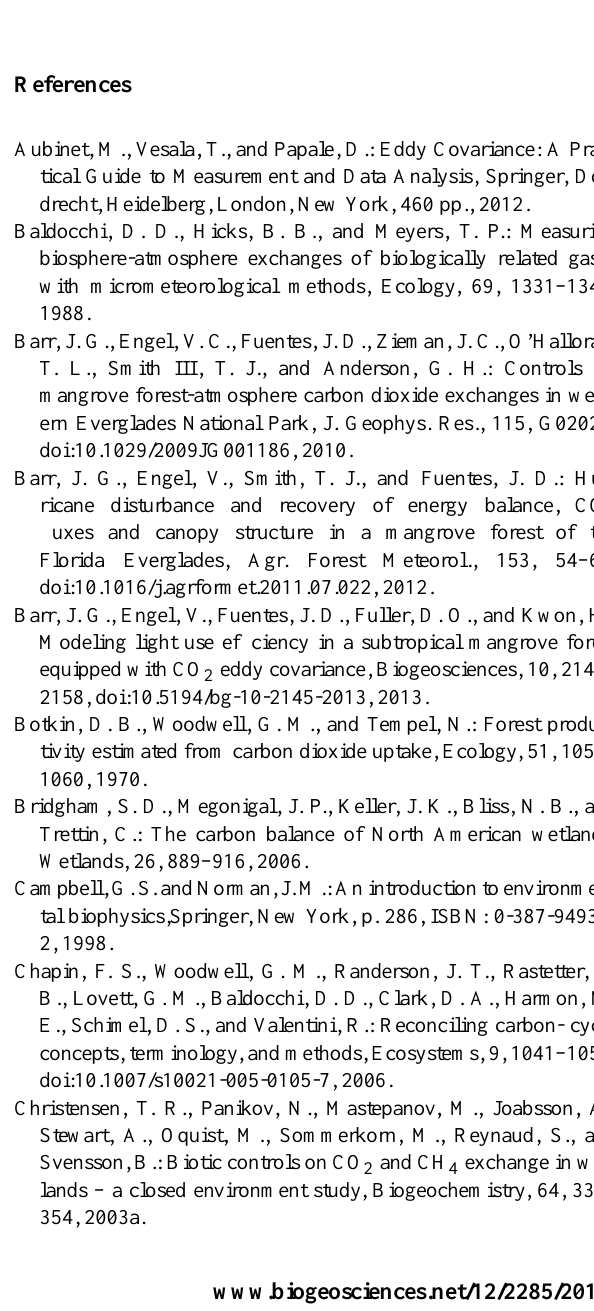
Table 6. Comparison of annual totals of NEE for different studies. Ecosystem NEE ∗ Climate Reference Taylor Slough (short sawgrass) − 50 Subtropics Schedlbauer (2010) Shark River Slough (short sawgrass) 45 Subtropics Jimenez (2012) Mangrove − 1170 Subtropics Barr (2010) Cypress Swamp − 900 to − 1000 Subtropics This study Dwarf Cypress − 400 to − 500 Subtropics This study Pine Upland − 750 to − 800 Subtropics This study White Oak − 296 Temperate Botkin (1070) Scarlet Oak − 274 Temperate Botkin (1070) Pitch Pine − 124 Temperate Botkin (1070) Everglades − 100 to > − 200 Subtropics Jones et al.